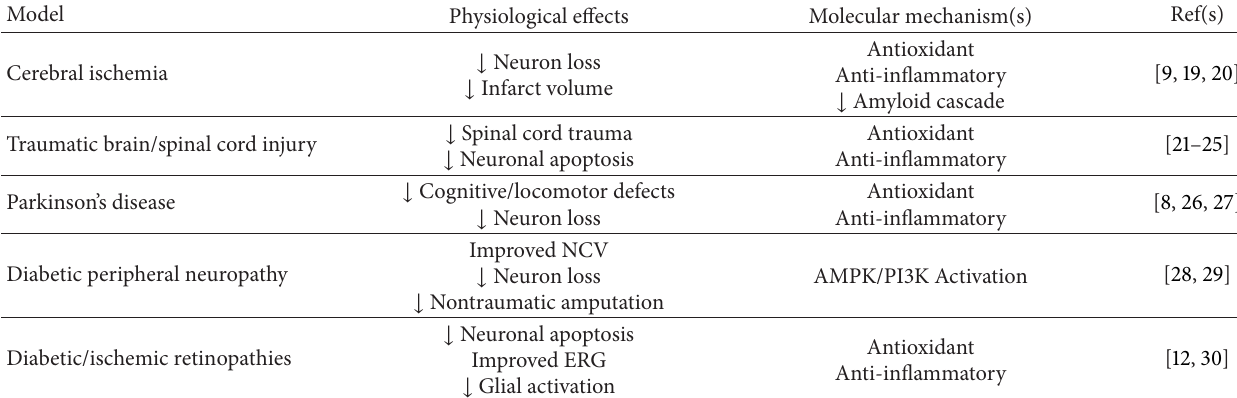
Table 1: Neuroprotective effects of PPAR 𝛼 and molecular mechanisms of